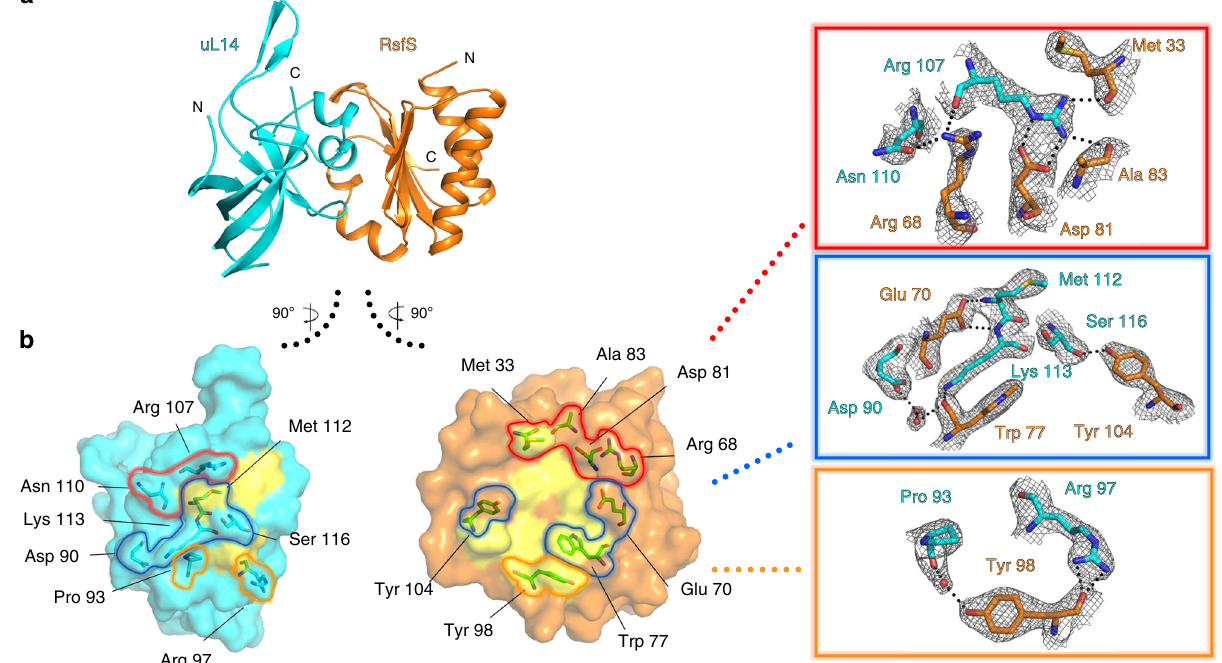
Fig. 3 The crystal structure of uL14 – RsfS complex and their interaction interface. a Atomic coordinates of one of the two uL14 – RsfS heterodimers from the asymmetric unit. The C α root-mean-square deviation (RMSD) between the two heterodimers was calculated to be 0.585 Å, suggesting that these two copies are essentially identical. The uL14 is shown in cyan, RsfS in gold; N and C stand for N-terminus and C-terminus of the proteins. b Amino acids of uL14 and RsfS proteins involved in contact formation. Hydrophobic regions are shown as yellow surfaces, contacting amino acids as sticks. Yellow, red, and blue frames show the H-bonds-forming amino acids form the respective regions marked on surface representation. H-bonds are shown as black dashed lines; the water molecules are shown as red ball; the crystallographic electron density is shown in mesh at 1.5 sigma